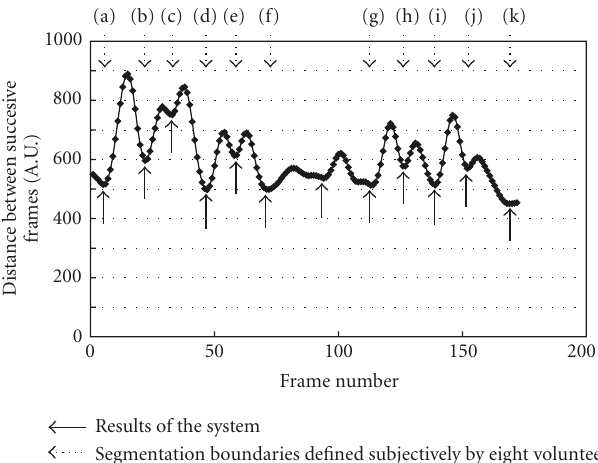
between histograms of successive frames. The dotted